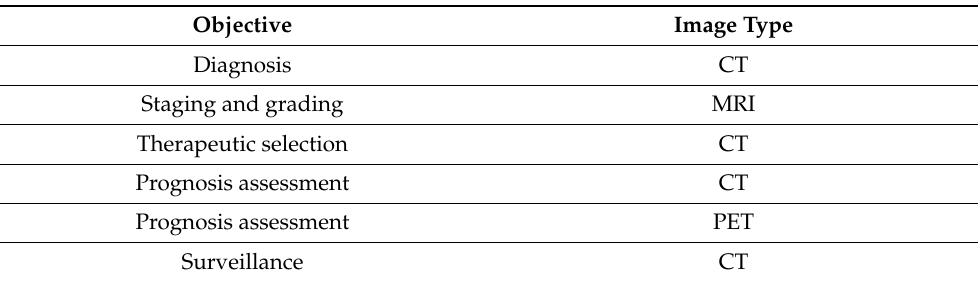
Table 2. HCC radiomics use